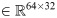
Schematic explanation of matrices κPCE→TCE (∈R64×32) and κTCE→cDCE (∈R32×16) containing kinetic isotopic coefficients κh,iPCE→TCE and κi,jTCE→cDCE, associated with reductive dechlorination of PCE to TCE and TCE to cDCE, respectively.Panel A: For the sake of simplicity, smaller matrices than the actual ones used are represented here. The green and white squares represent isotopocule fractionation factors different from zero and equal to zero, respectively. Columns i and j correspond to the column of factors associated with the production of the ith isotopocule of TCE from PCE and the jth isotopocule of cDCE from TCE, respectively. The blue shade in panel A corresponds to the factors associated with degradation of the hth isotopocule of PCE to TCE which are further illustrated by the blue arrows in panel B. Similarly, the orange shade in panel A corresponds to the factors associated with degradation of the ith isotopocule of TCE to cDCE which are illustrated by the orange arrows in panel B.